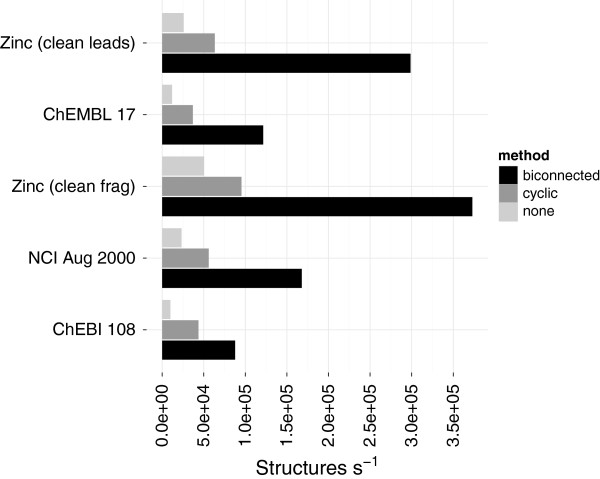
Preprocessing cycles. The impact of varied preprocessing when computing the minimum cycle basis (MCB). None indicates the MCB was computed on the entire graph whilst cyclic indicates the MCB was computed on a subgraph of only the cyclic vertices and edges. The biconnected preprocessing computed the MCB only on the biconnected component which were not simple elementary cycles. The performance includes the both the application of the preprocessing (i.e. finding the biconnected components) and the computation of the MCB. The time taken to convert the CDK objects (Table 2) is not included.